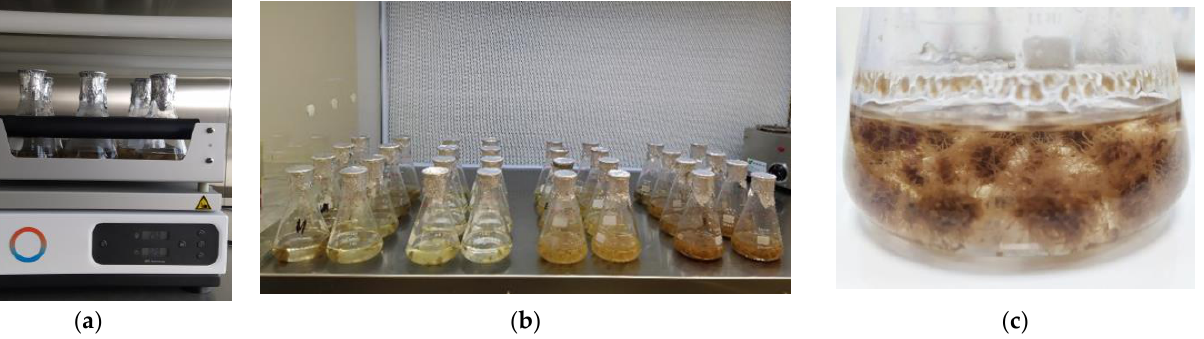
Figure 3. In vitro culture of Origanum dictamnus L. roots in liquid media: (a) flasks onto continuous rotary shaker agitated at 120 rpm, (b) all treatments into flasks onto laminar hood flow and (c) root biomass growth and formation of new adventitious roots over primary ones after 40 days of culture.